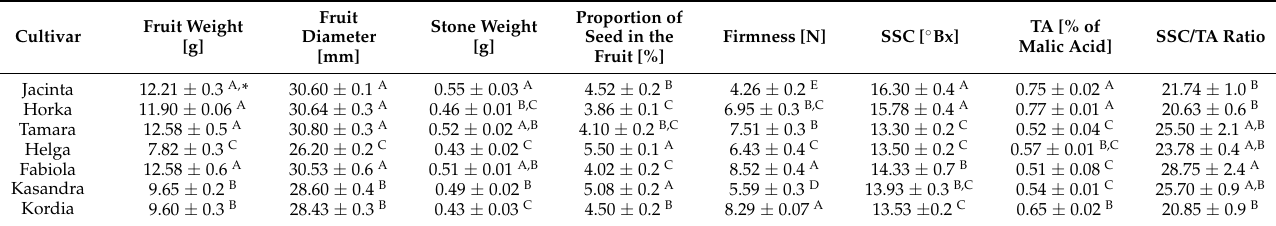
Table 2. Fruit quality characteristics with standard errors, depending on the